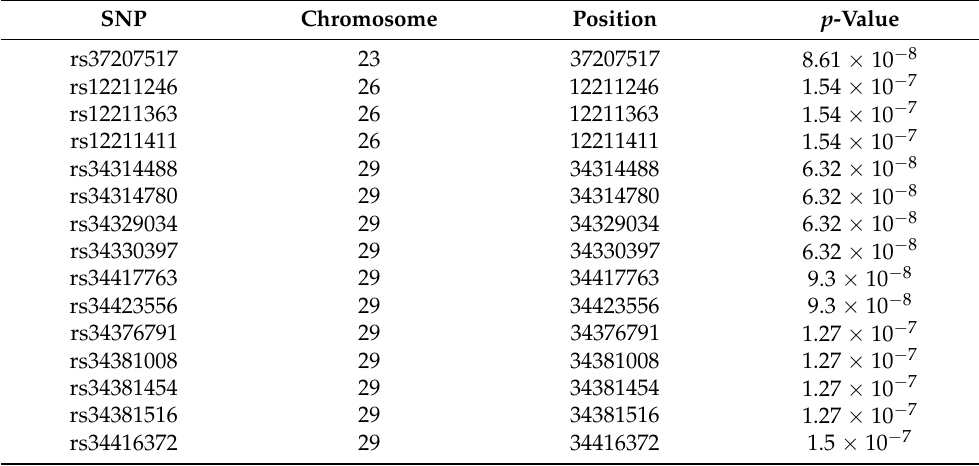
Table 4. SNPs in segment 3 associated with hind leg circumference, as determined by NGS dataset